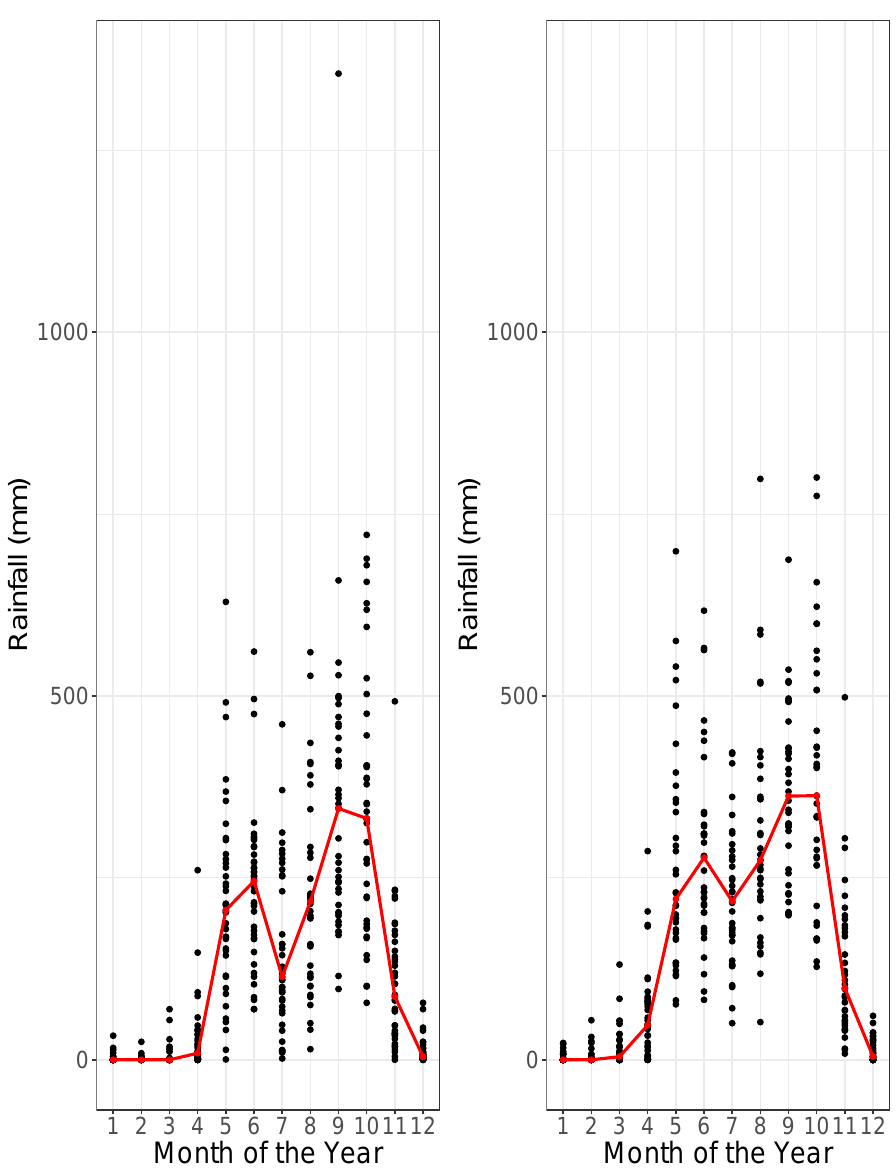
Figure 2. Annual cycle of total monthly rainfall values at the Liberia station ( left ) from 1980 to 2020 and at the Nicoya station ( right ) from 1980 to 2016. The red line represents the observed median rainfall in each